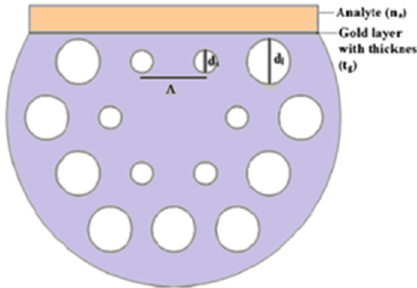
Figure 41. Cross-section of the proposed graphene-silver-based SPR sensor with external analyte channel (Figure courtesy from the reference [111]).